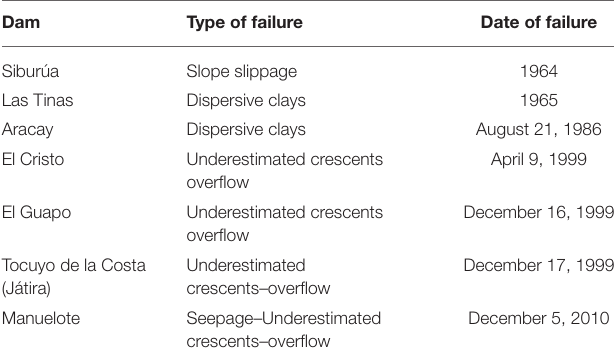
TABLE 4 | Failure Dams in